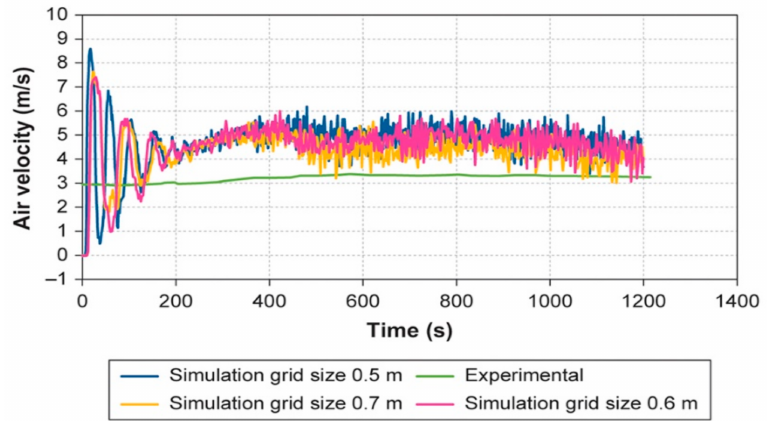
Figure 5. Air velocity, 458 m downstream, 2.9 m above road